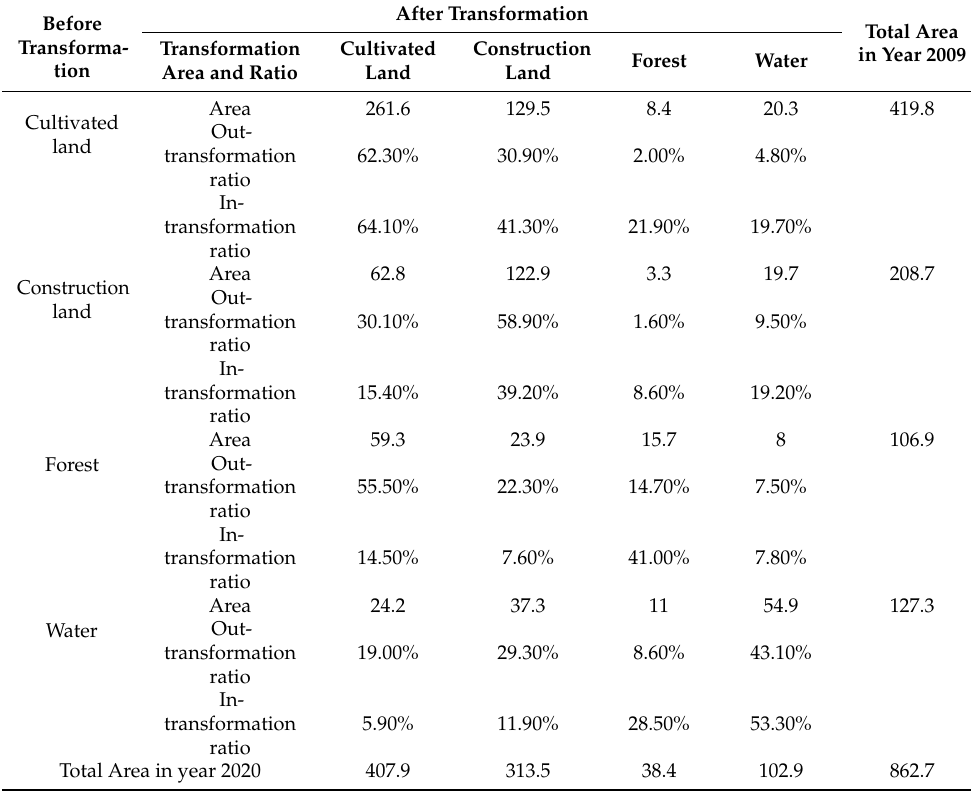
Total Area in Year 2009Transformation